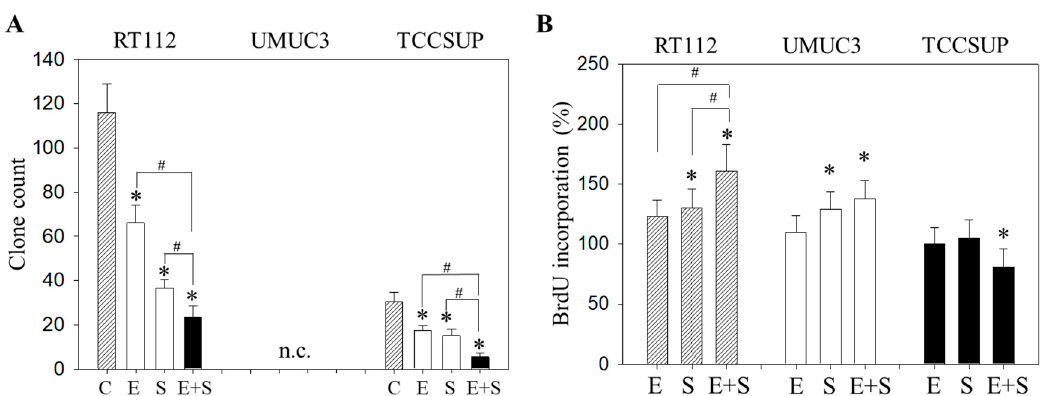
Figure 2. Evaluation of clonogenic growth ( A ) and BrdU incorporation ( B ) under short-term application of 0.5 nM everolimus (E) or 2.5 µM sulforaphane (S) or 0.5 nM everolimus + 2.5 µM sulforaphane (E + S). Control cells (C) remained untreated. RT112 clones were counted at day 8 and TCCSUP at day 10 following incubation. UMUC3 cells did not form clones (n.c.- not counted). The BrdU assay was carried out with synchronized cells with untreated control cells set at 100%. ∗ indicates significant difference to untreated controls. # indicates significant difference between the mono and the combined applications.